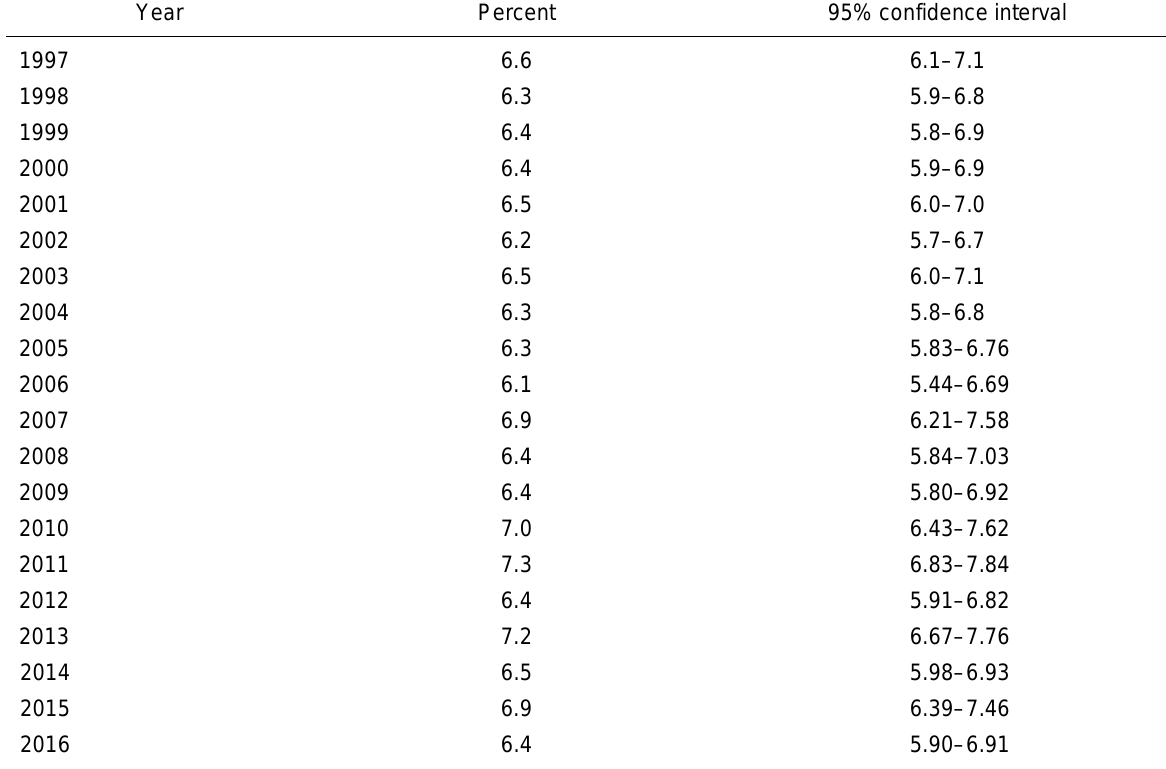
Data table for Figure 12.1. Percentage of adults aged 65 and over who needed Data tables for Figures 12.1–12.3: help with personal care from other persons: United States,